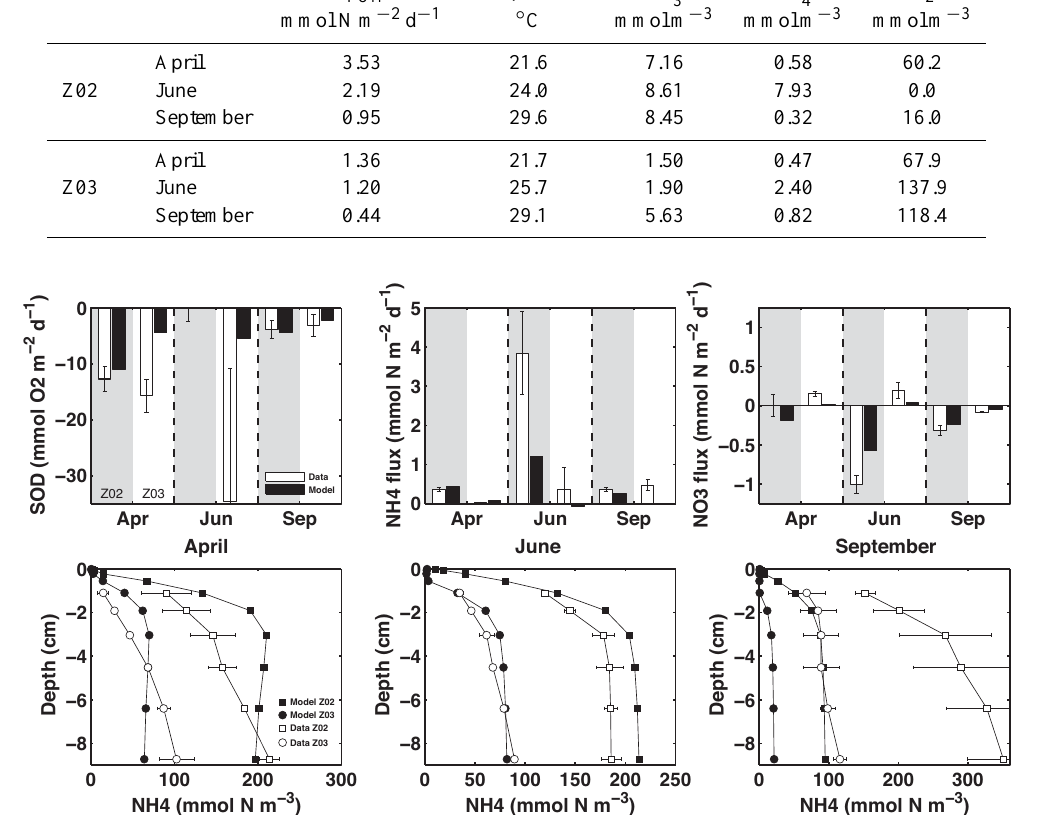
Figure 2. Model–data comparison of sediment–water fluxes (top row) and NH + use the optimized parameter set